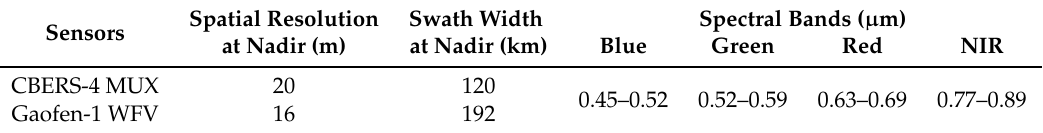
Table 2. Characteristics of CBERS-4 MUX and Gaofen-1